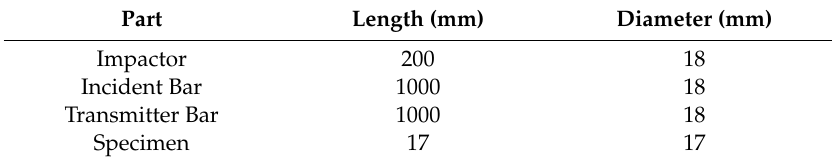
Table 5. Input parameter for modified crushable foam and Fu Chang foam material model in LS- DYNA.